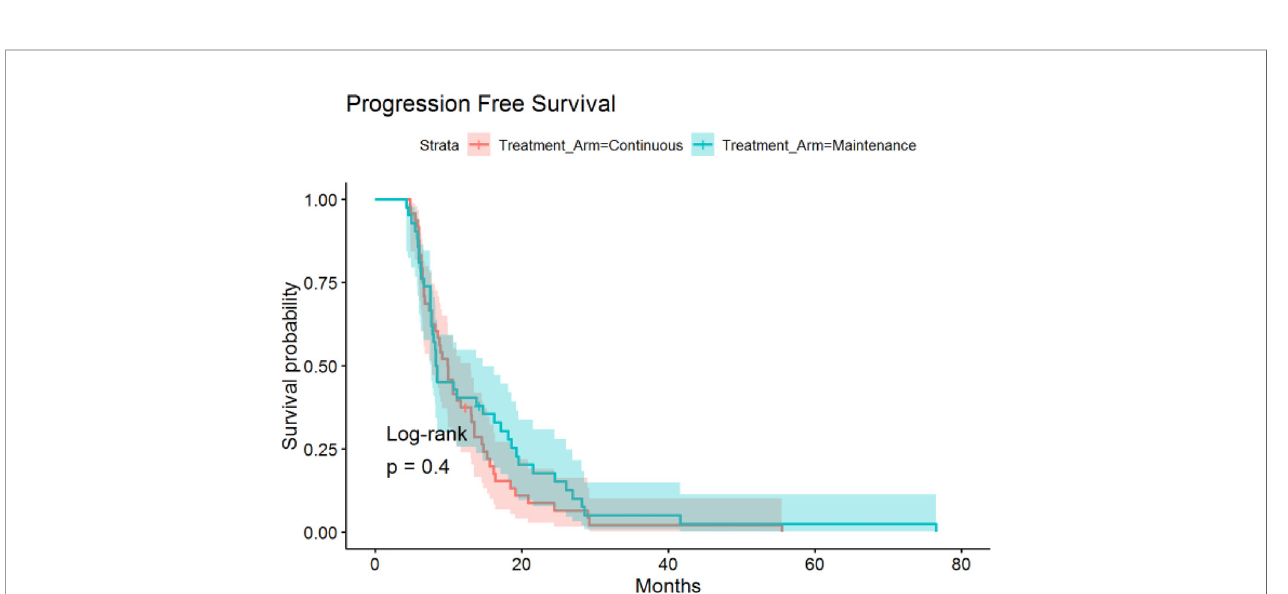
FIGURE 2 | Progression-Free Survival in Continuous vs Maintenance